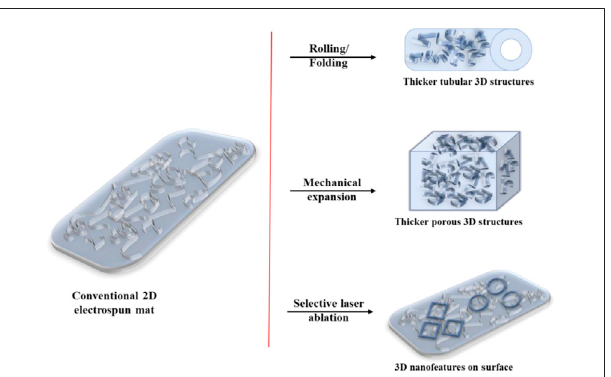
FIGURE 4 | Electrospun mat possible